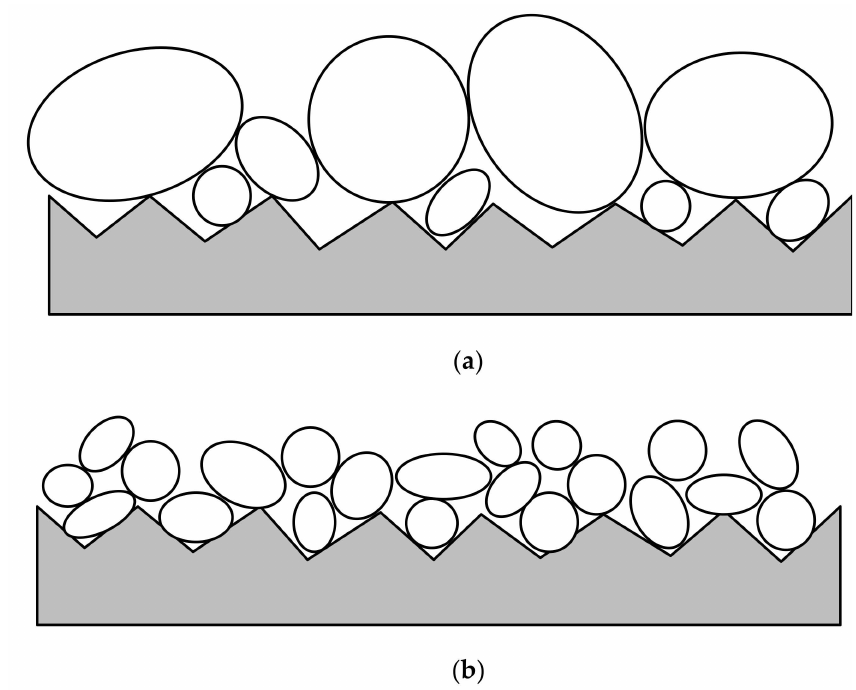
Figure 11. Sand with large particles on the interface: ( a ) before shear; ( b ) after